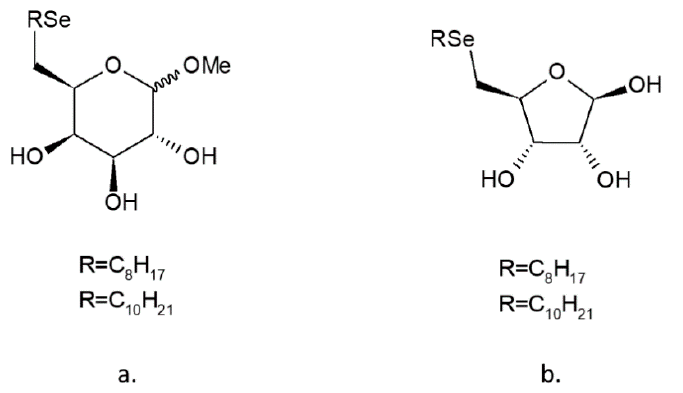
Figure 7. Examples of the alkylselenide structures derived from pyranose ( a ) and furanose ( b ), synthesized by Vargas et. al. [242].